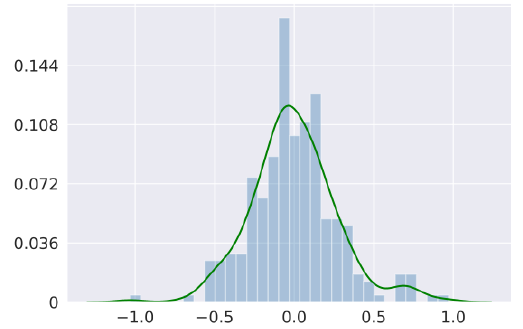
Figure 8. Qualitative result of the distribution of the channel-wise factor β